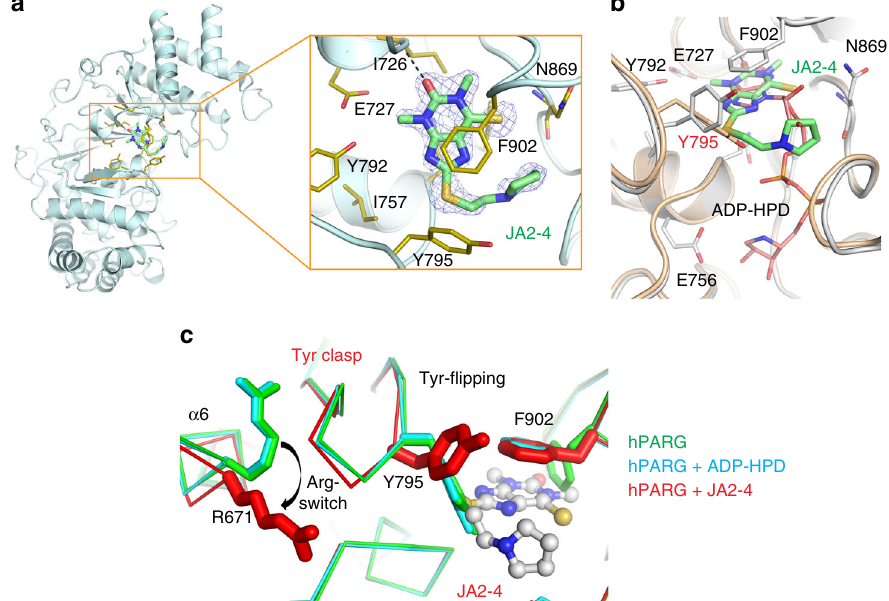
Fig. 2 JA2-4 binds to the adenine-binding pocket of hPARG by virtue of the fl exibility of the Tyr clasp. a 1.7 Å crystal structure of human PARG bound to JA2-4 reveals speci fi c and extensive inhibitor interactions with the adenine-binding pocket. The 6´-thiocarbonyl sulfur of JA2-4 was assigned by comparing the size and orientation of the electron density to that of the corresponding 6´-carbonyl oxygen of JA2120 (Fig. 3b). JA2-4 is shown with a Fo-Fc map (contoured at 2 σ ) that was calculated prior to the addition of JA2-4 to the model. JA2-4 bound PARG catalytic domain shown in the enlarged box. b A structural comparison of the binding interactions of JA2-4 and ADP-HPD is consistent with a competitive inhibition mechanism for JA2-4. The structure of hPARG bound to ADP-HPD (wheat) is overlaid onto that bound to JA2-4 (white). The methylxanthine core of JA2-4 makes extensive interactions and occupies the same binding site as the adenosine moiety of ADP-HPD and. c The Tyr clasp changes conformation to enable binding of JA2-4. JA2-4 binding shifts the position of the Tyr clasp in concert with the rotation of the Tyr795 side chain and rearrangement of Arg671. The structural fl exibility of the Tyr clasp creates room for JA2-4 and facilitates interactions with Asn869 and I726 that contribute to potent inhibition of PARG activity (IC 50 of 0.9 μ